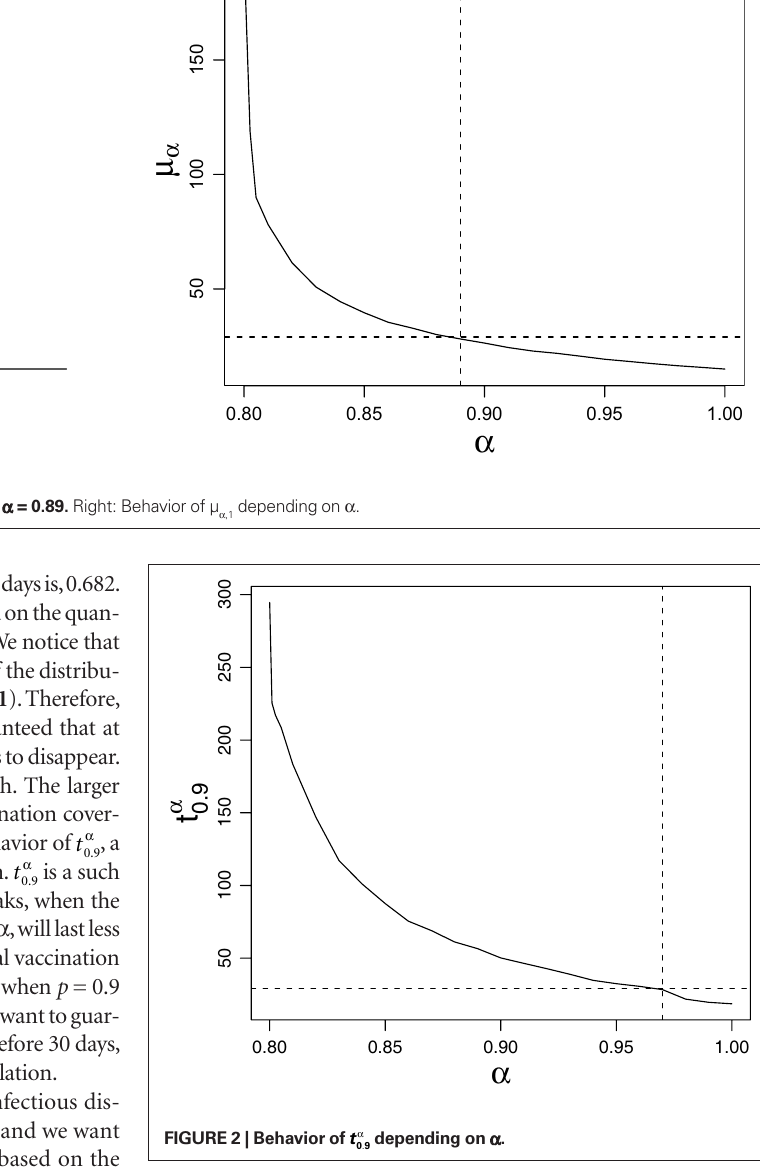
α depending on α 09 .